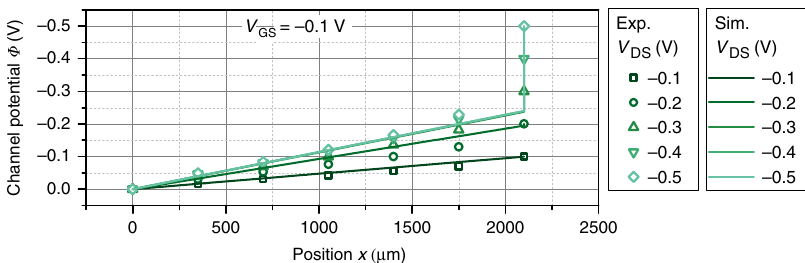
Fig. 9 Channel potential. Comparison of the experimentally obtained potential pro fi le along the transistor channel at V GS = − 0.1 V (symbols) and the calculated potential pro fi le using the parameters summarized in Supplementary